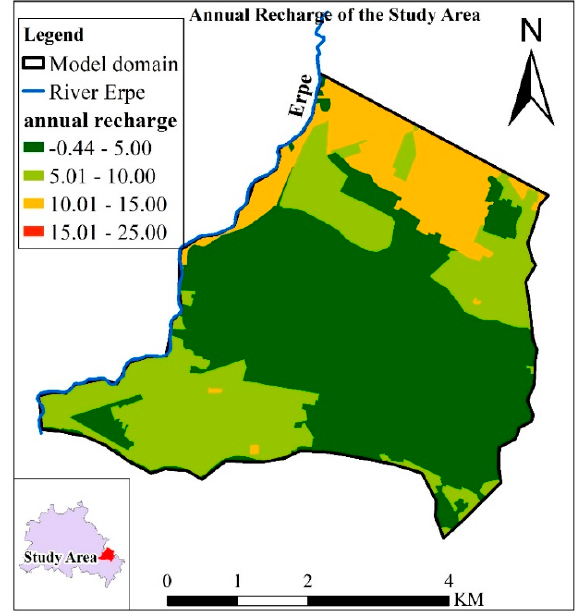
Figure 2. Map of the annual recharge of the study area.